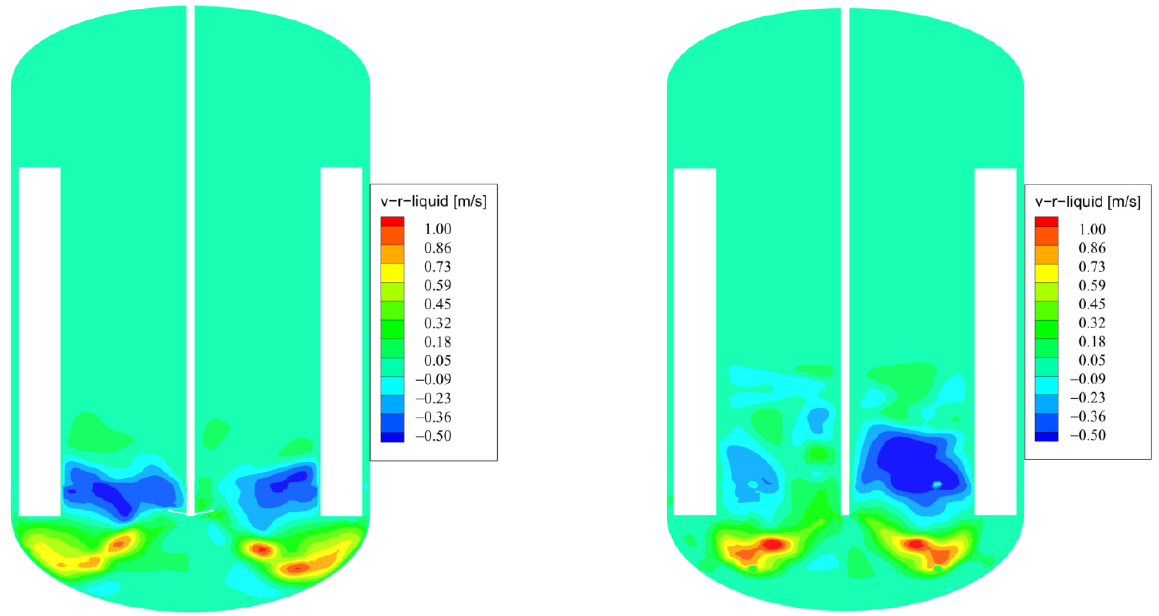
Figure 8. Radial velocity distribution of the liquid phase: ( a ) flow started from the solid phase fully sedimented; ( b ) flow started from the solid phase dispersed in the entire volume of